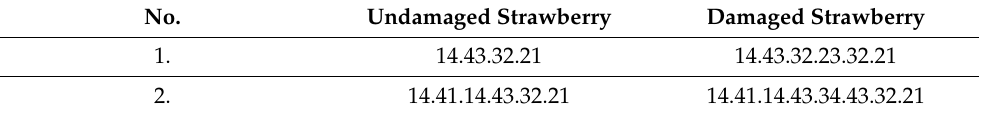
Figure 10. An example of undamaged fruit. Its contour is described by the sinquad 14.41.14.43.32.21. Table 4. The structural description of the contour of undamaged and damaged fruits by using